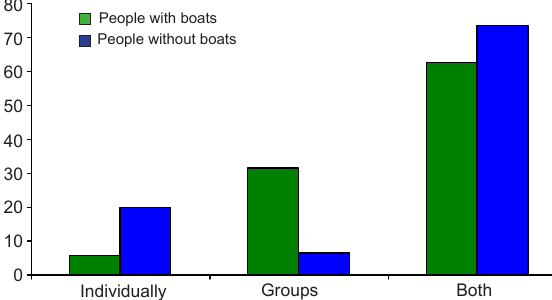
Figure 2. Perception of fishermen about dolphin distribution in the Upper Ganges River.